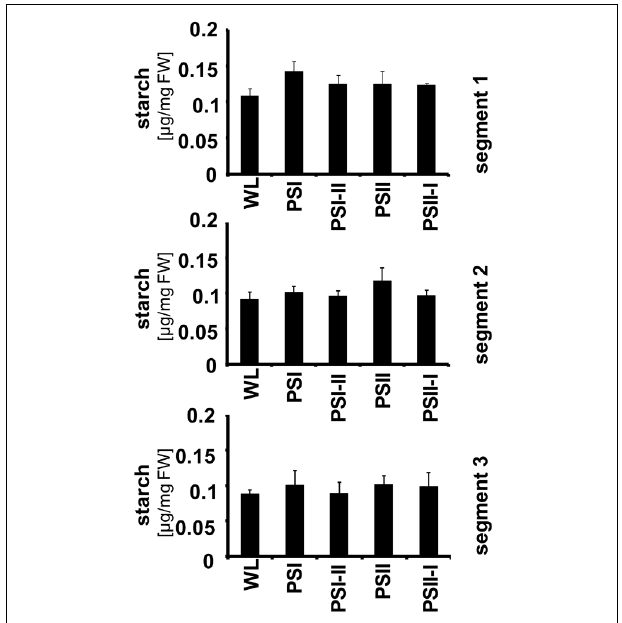
FIGURE 6 | Starch accumulation in segments of maize seedlings grown in long-term under the different light quality regimes. Starch per fresh weight (FW) was determined from the three leaf segments (indicated on the right) as described before. Growth light regimes of the respective plant samples are indicated at the bottom of each panel. All determinations were done in triplicate, standard deviations are